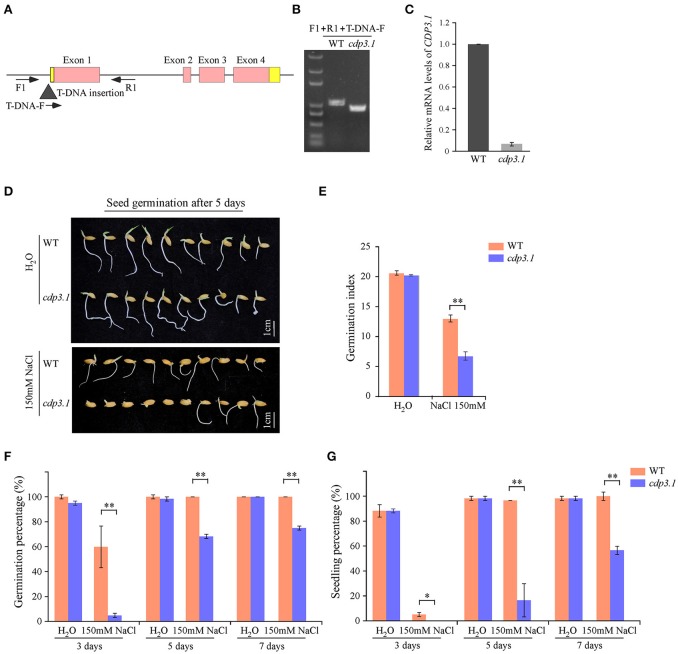
Comparison of seed germination between wide type (WT) and CDP3.1 mutant line (cdp3.1) under water and salt stress conditions. (A) Gene structure of CDP3.1 with a T-DNA insertion and the locations of the primers used for PCR analysis. Black triangle represents the T-DNA. Red and yellow boxes represent exons and UTR of CDP3.1, respectively. Solid lines represent introns. F, R, and T-DNA-F primers used for genotyping PCR. (B) PCR of genomic DNA from WT and cdp3.1. (C) Quantitative RT-PCR analysis of CDP3.1 mRNA level from WT and cdp3.1 seeds. The mRNA level of CDP3.1 was normalized to that of 18S ribosomal RNA gene control. (D) Seed germination of WT and cdp3.1 after 5 days under water and 150 mM NaCl conditions. (E) Germination index of WT and cdp3.1 after 10 days under water and 150 mM NaCl conditions. (F) Germination percentage of WT and cdp3.1 after 3, 5, and 7 days under water and 150 mM NaCl conditions. (G) Seedling percentage of WT and cdp3.1 after 3, 5, and 7 days under water and 150 mM NaCl conditions. Each column represents means ± standard deviation. * and ** indicated the significant difference at 5 and 1% levels, respectively.